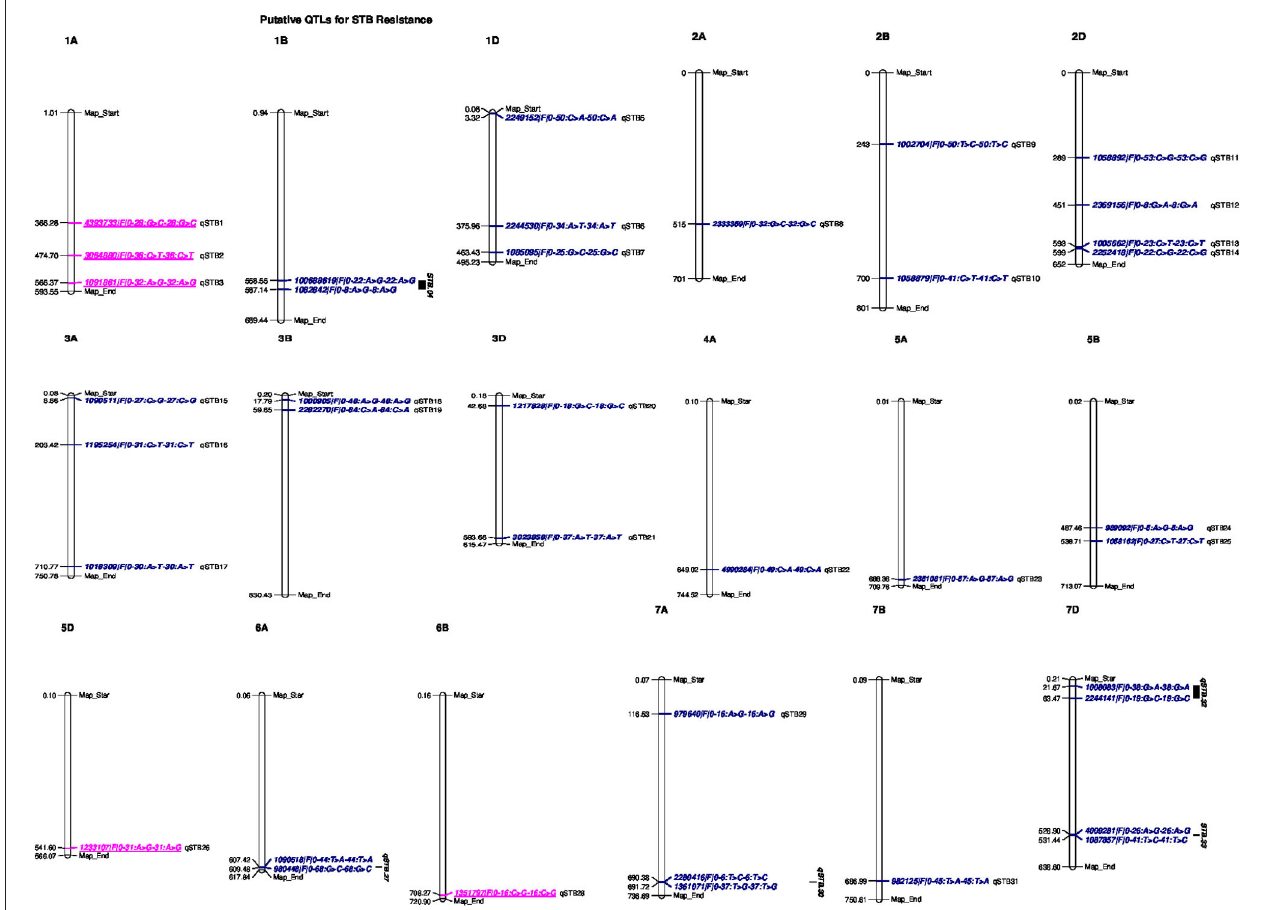
FIGURE 5 | Genomic positions of detected putative QTLs effective for STB resistance. Significant DArTSeq SNPs are presented according to their physical positions on chromosomes in millions base pairs. The putative QTLs identified in this study for the MTAs are indicated on the right sides of the bars. Underlined MTAs (marked in pink) on the right sides of the chromosomes could be potentially novel loci in this